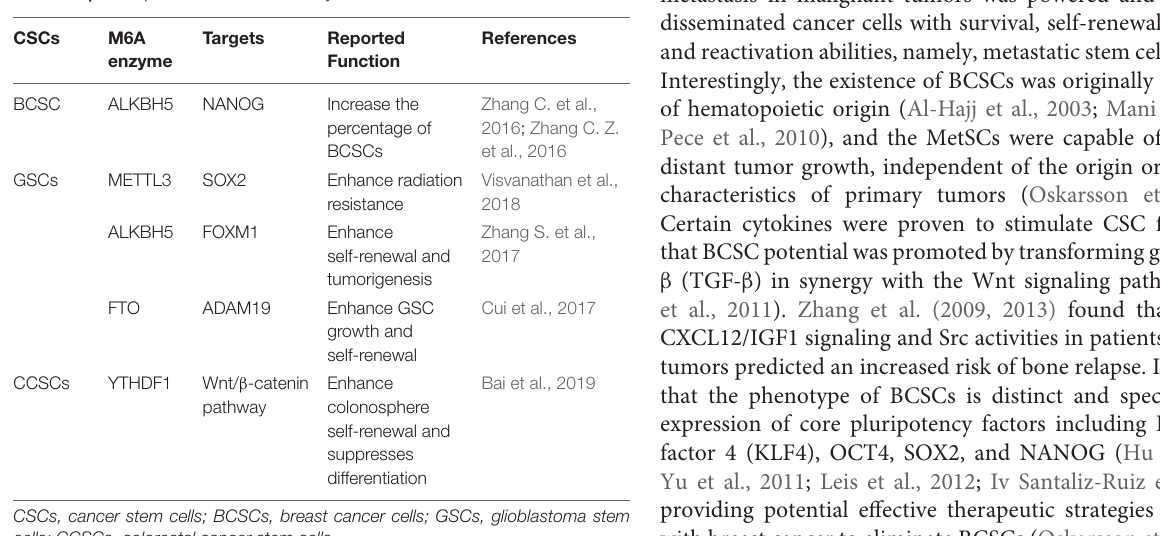
TABLE 1 | The reported roles of M6A enzymes in CSCs of solid